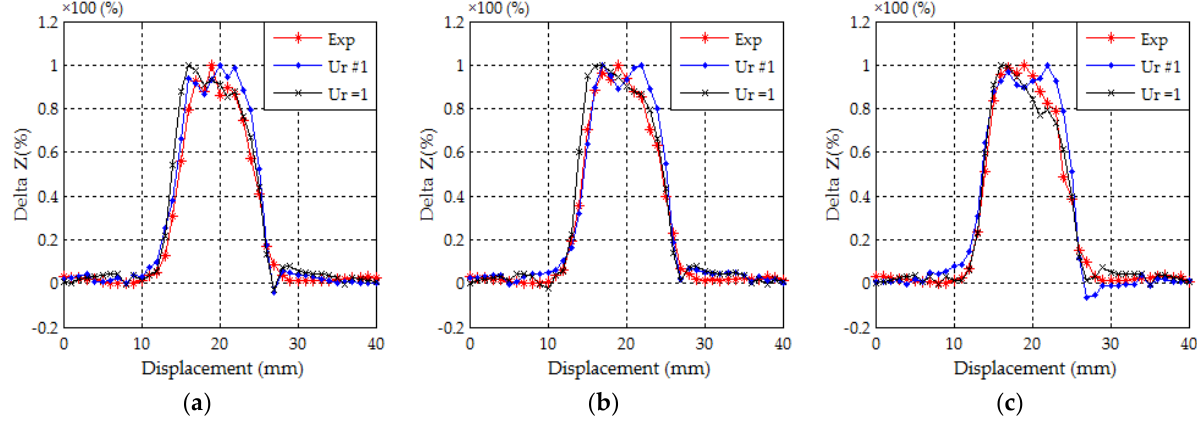
Figure 11. Impedance variation in (%) at 50 kHz with ( a ) depth = 0.3 mm, ( b ) depth = 0.5 mm, and ( c ) depth = 1 mm.